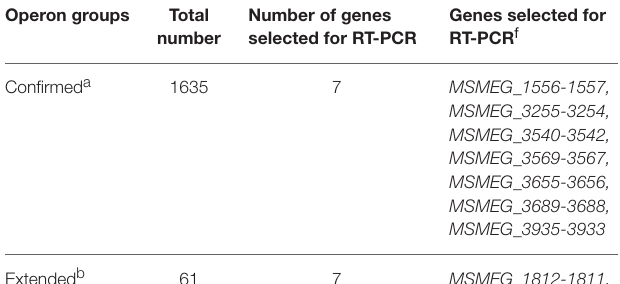
TABLE 2 | Operon prediction in M. smegmatis mc 2